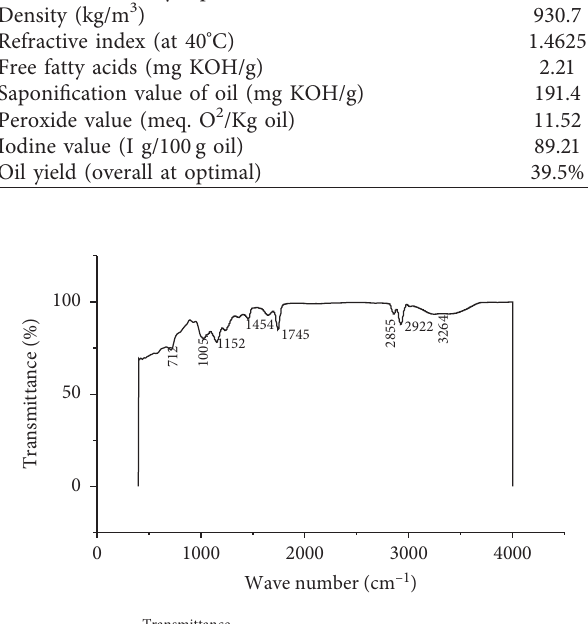
Figure 5: FT-IR spectrum of Moringa stenopetala seed